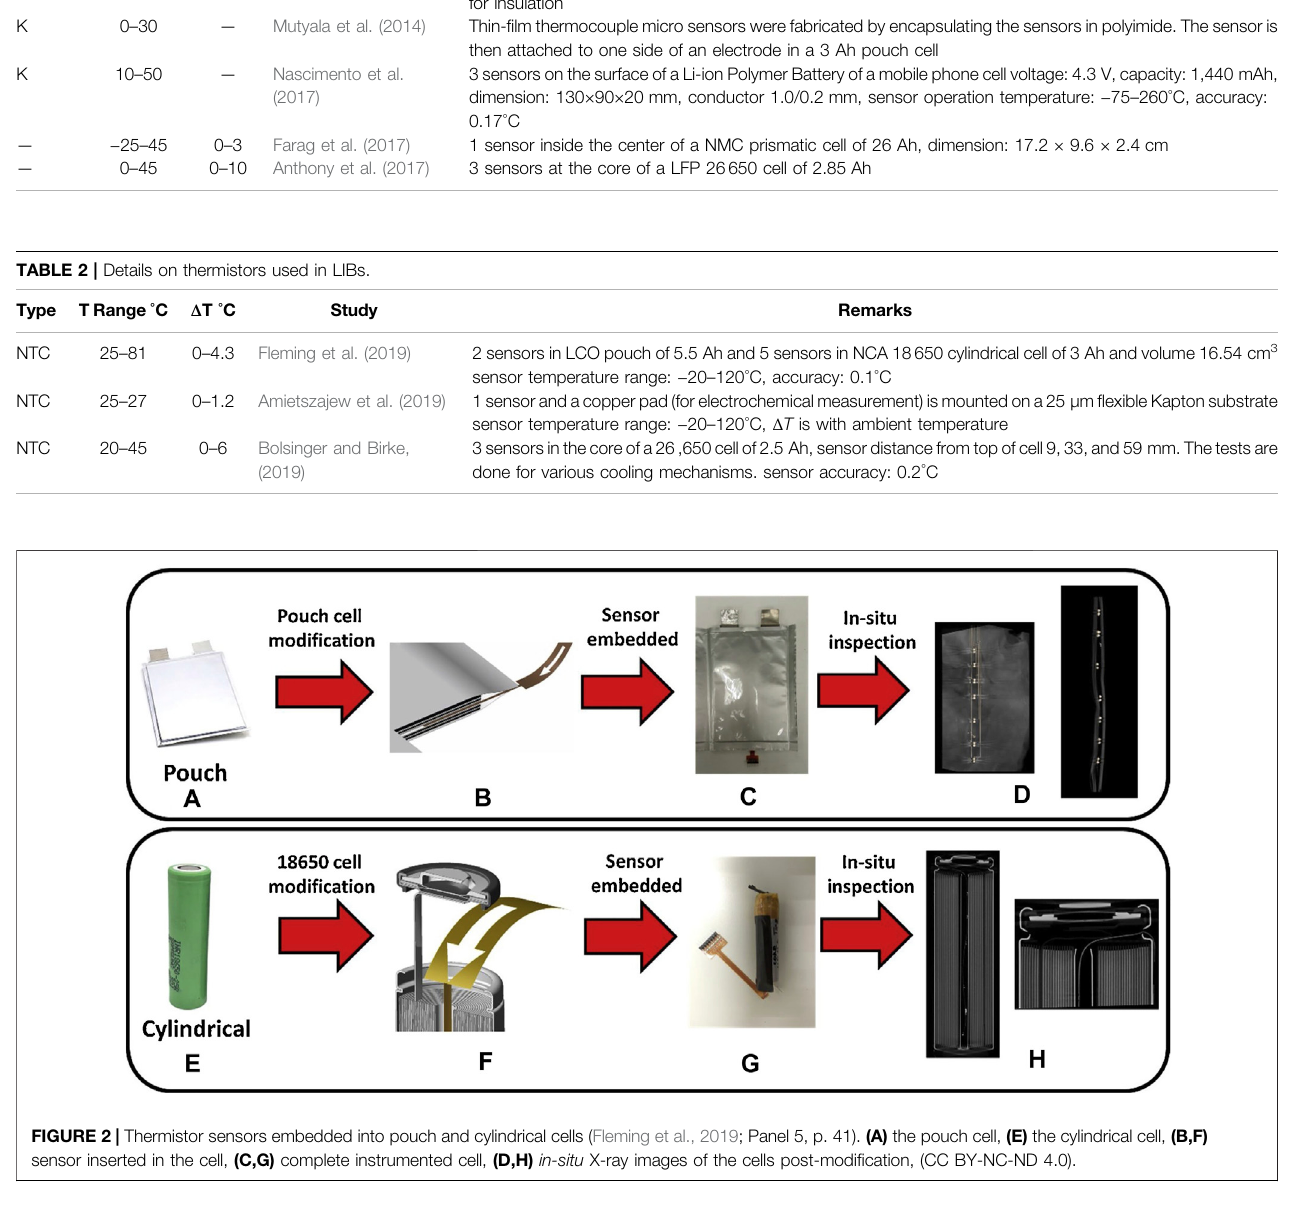
Frontiers in Chemical Engineering |